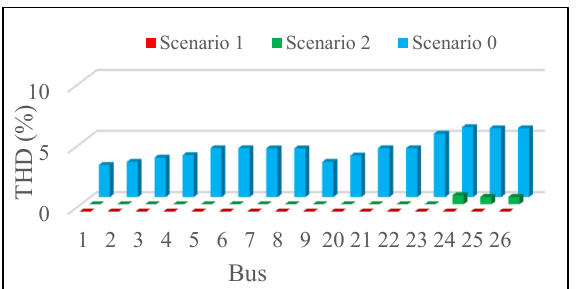
Figure 15. The THD value of network voltages in a network with multiple nonlinear loads and multiple SACAPFs (scenarios are defined in Table 5).